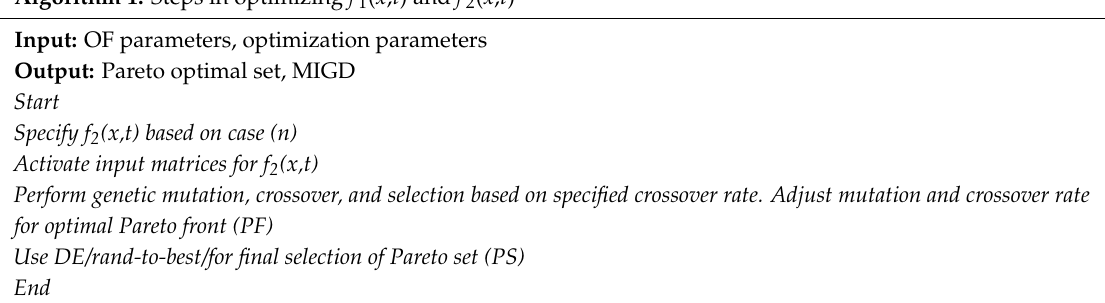
Algorithm 1. All of the simulations are done using PlatEMO open source MATLAB-based platform [29]. Algorithm 1. Steps in optimizing f 1 ( x , t ) and f 2 ( x , t )